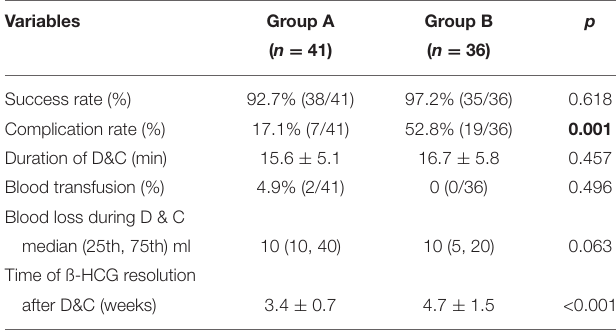
TABLE 2 | Comparison of effects and outcomes between group A and group